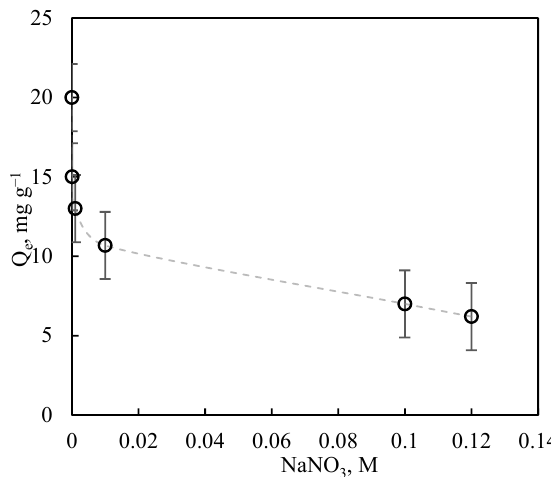
Figure 8. Influence of ionic strength on Cu (II) adsorption on sludges (pH = 5; 25 °C; C 0 = 25 mg L −1 , 0.1 g of adsorbent).